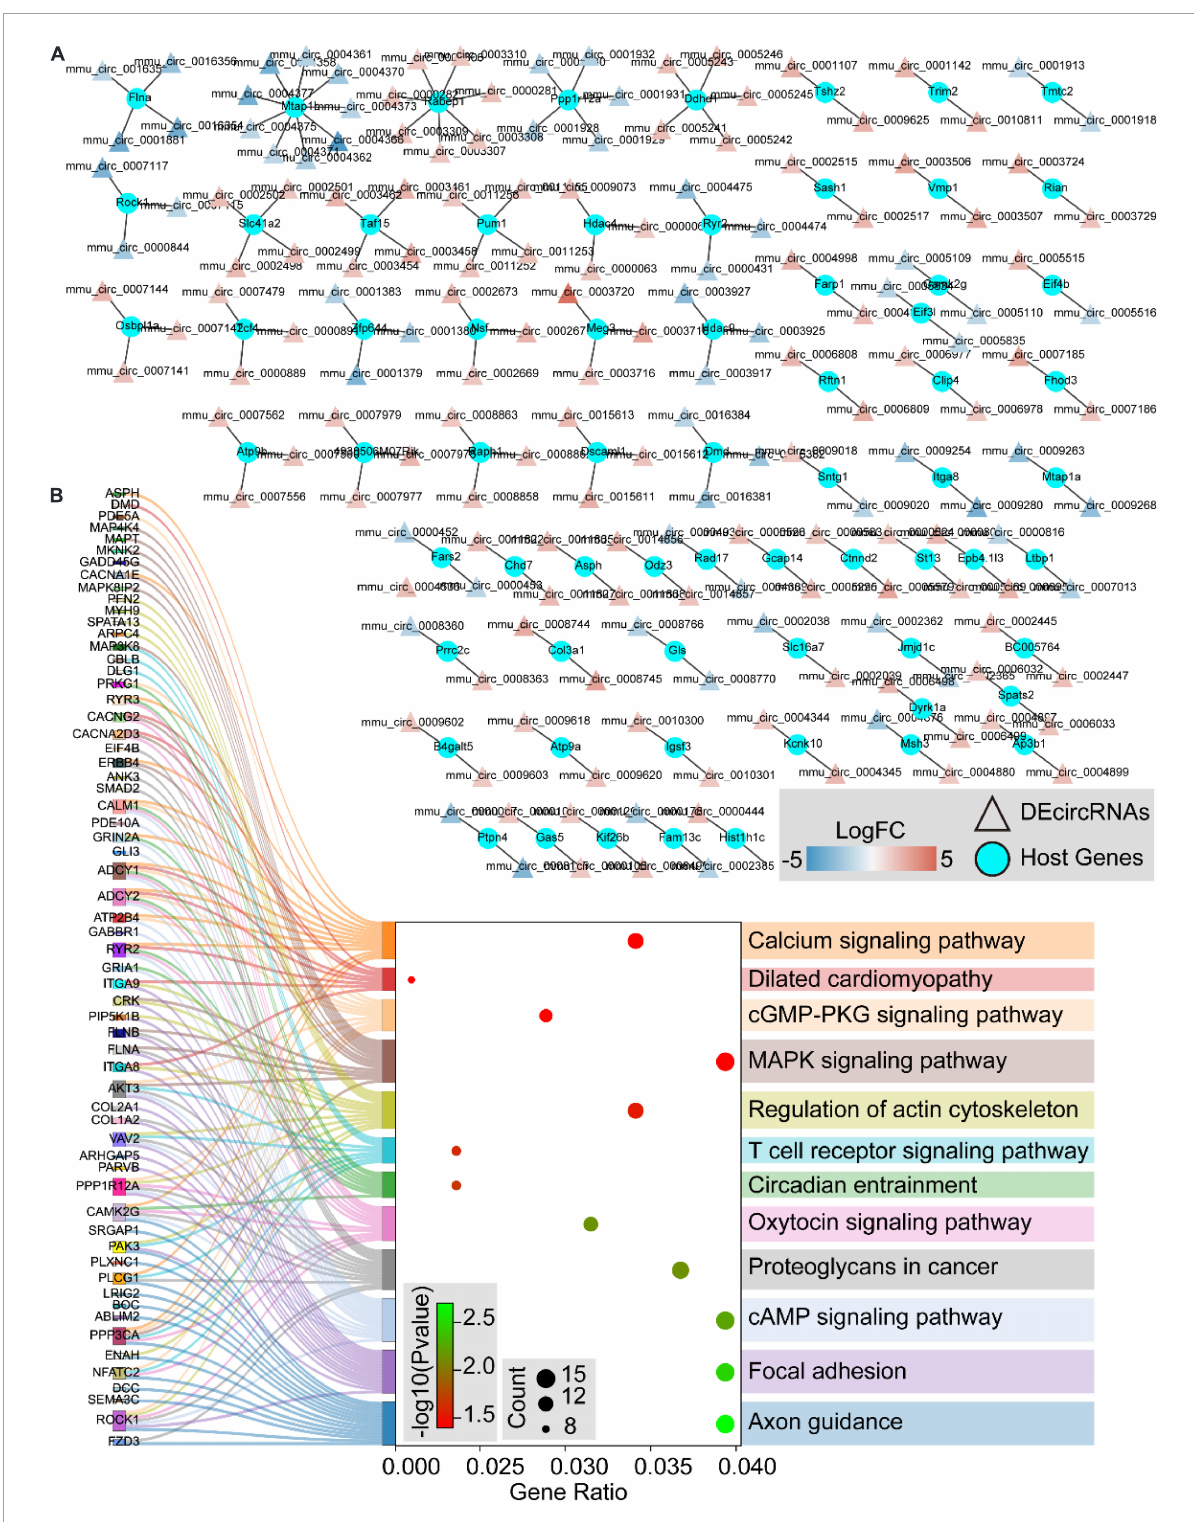
FIGURE9 The host genes of differentially expressed circular RNAs (DEcircRNAs). (A) The networks of DEcircRNAs host genes in aortic dissection (AD) tissues induced by chronic intermittent hypoxia (CIH) and Ang II. The red to blue color gradient indicates up- to downregulation of DEcircRNAs, indicated by logFC; circular nodes represent mRNAs and triangular nodes represent circRNAs. (B) Sankey’s diagram showing the classification of DEcircRNAs host genes in AD tissues induced by CIH and Ang II, based on GO and KEGGs